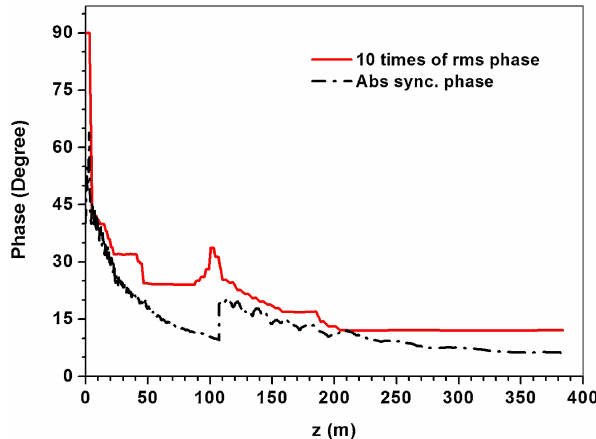
FIG. 18. Absolute synchronous phase and 10 times RMS phase width along main linac.